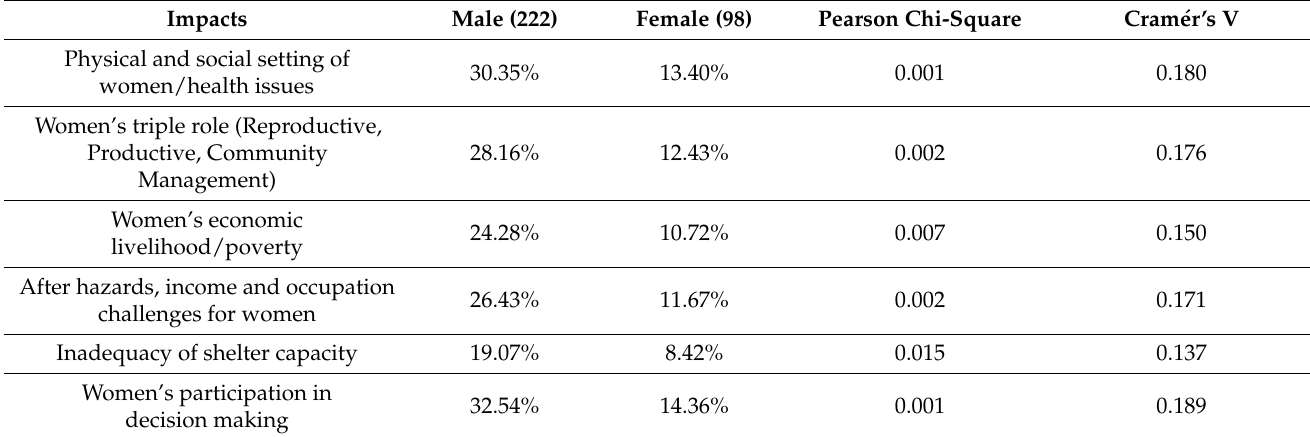
Table 15. refer back to Table 7. represents women-centered adaptation measures in the